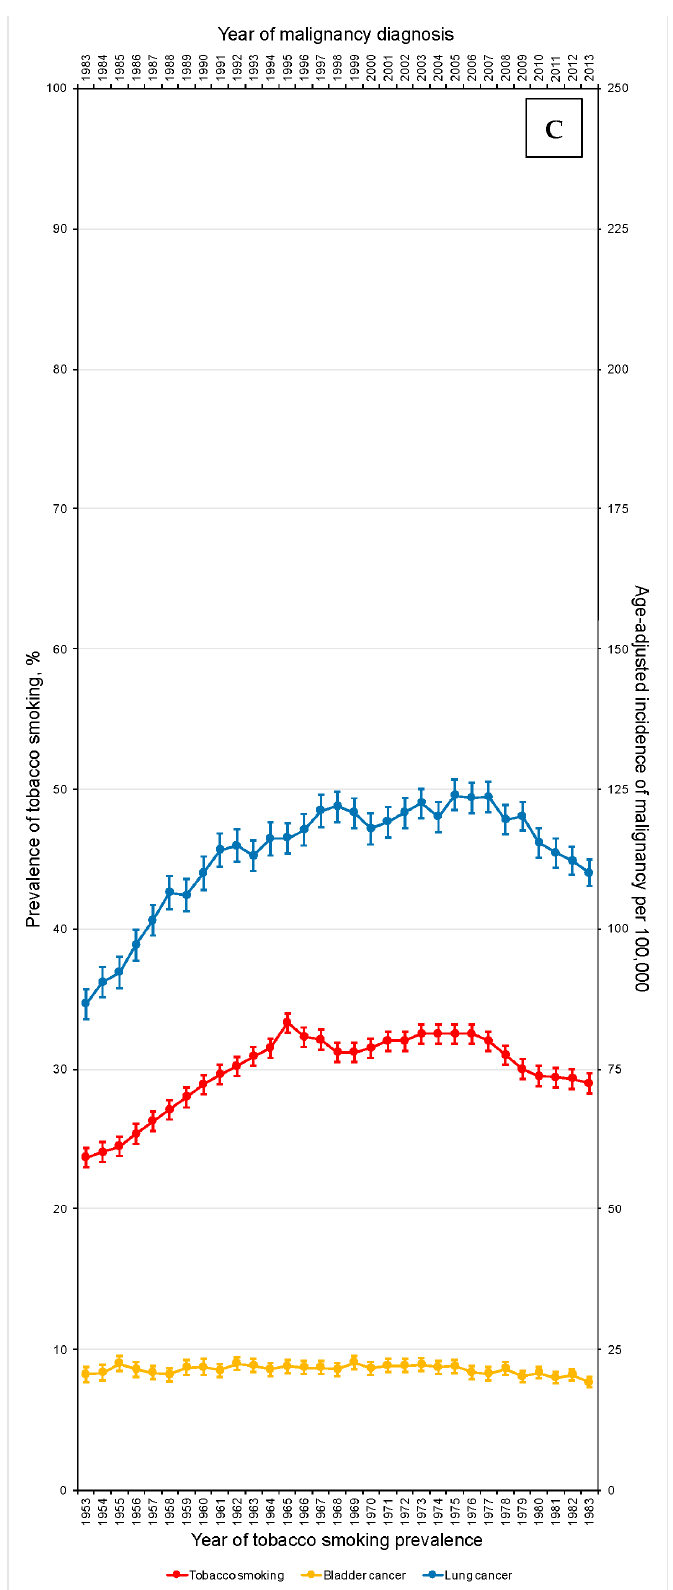
Figure 1. Impact of increasing tobacco smoking prevalence on bladder and lung cancer incidence in the ( A ) overall, ( B ) male, and ( C ) female United States populations over the past-half century.